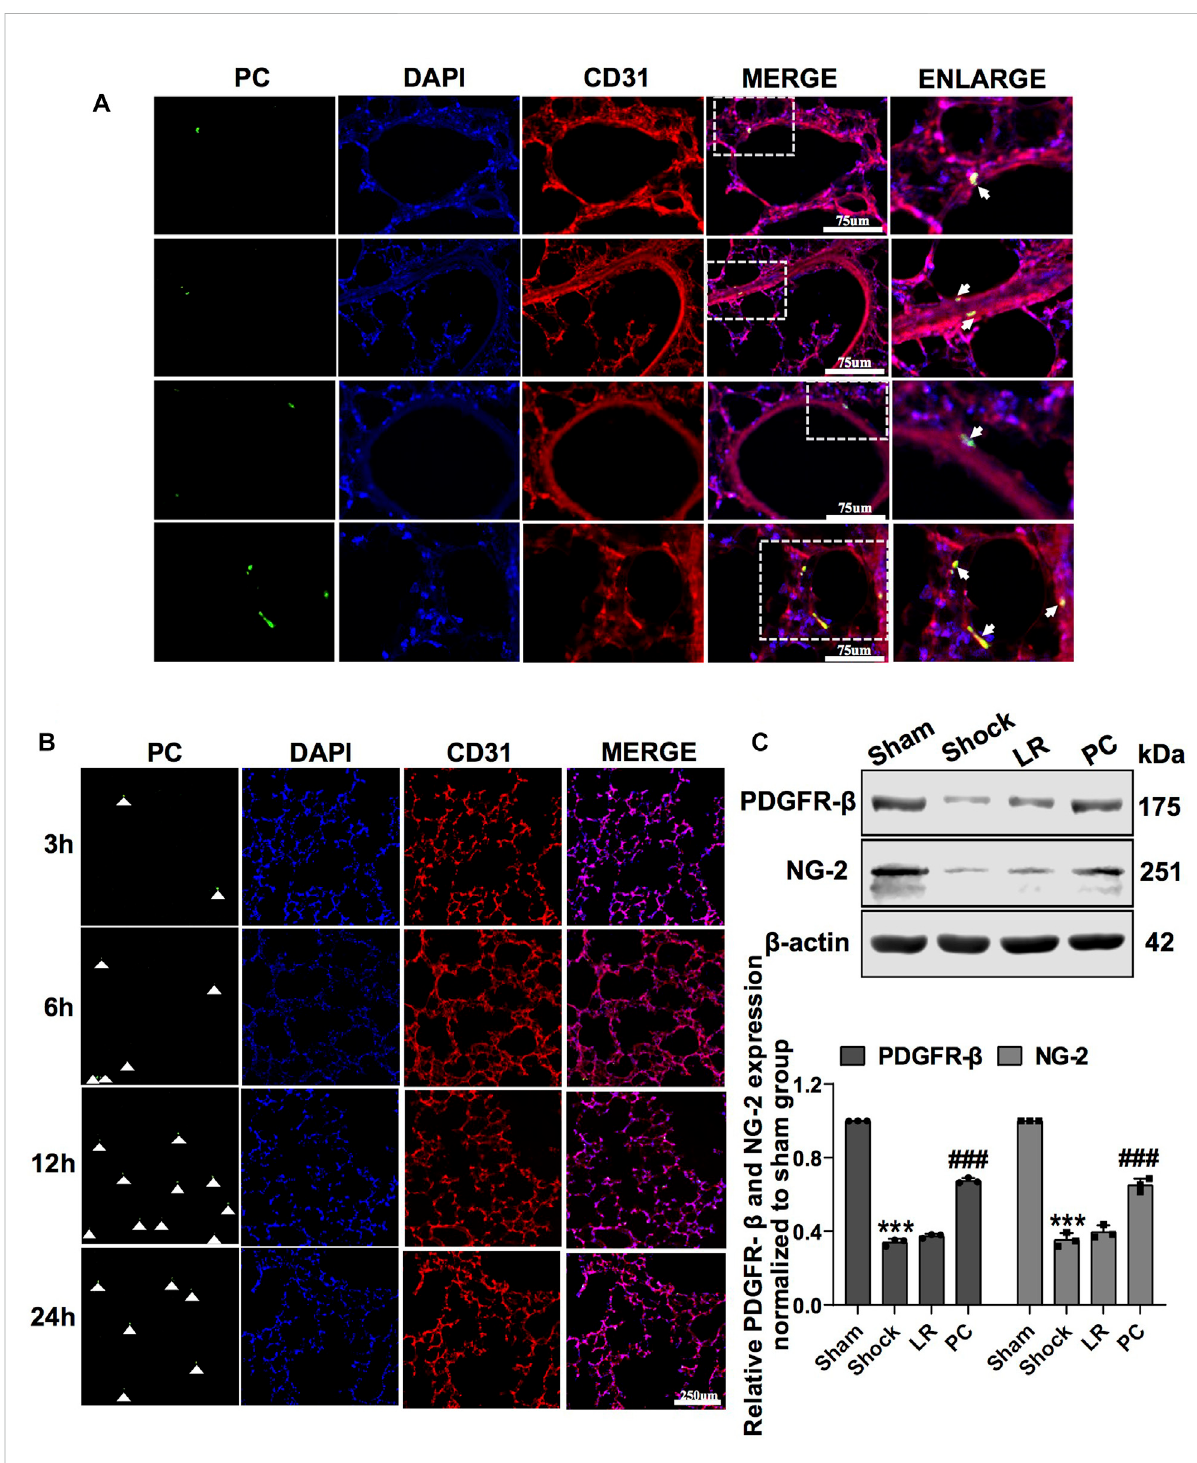
FIGURE 2 ColonizationofexogenousGFP-PCsinpulmonaryvessels. (A) LocationofGFP-PCscolonizedinthepulmonaryvessels( n =8). (B) Colonization of GFP-PCs in the pulmonary vessels at different time points determined by immuno fl uorescence ( n = 8). (C) Protein expression of PDGFR- β and NG-2 in pulmonary veins determined by WB ( n = 12 pulmonary veins from three rats). *** p < 0.001 compared with the sham group. ### p < 0.001 compared with the LR group (one-way